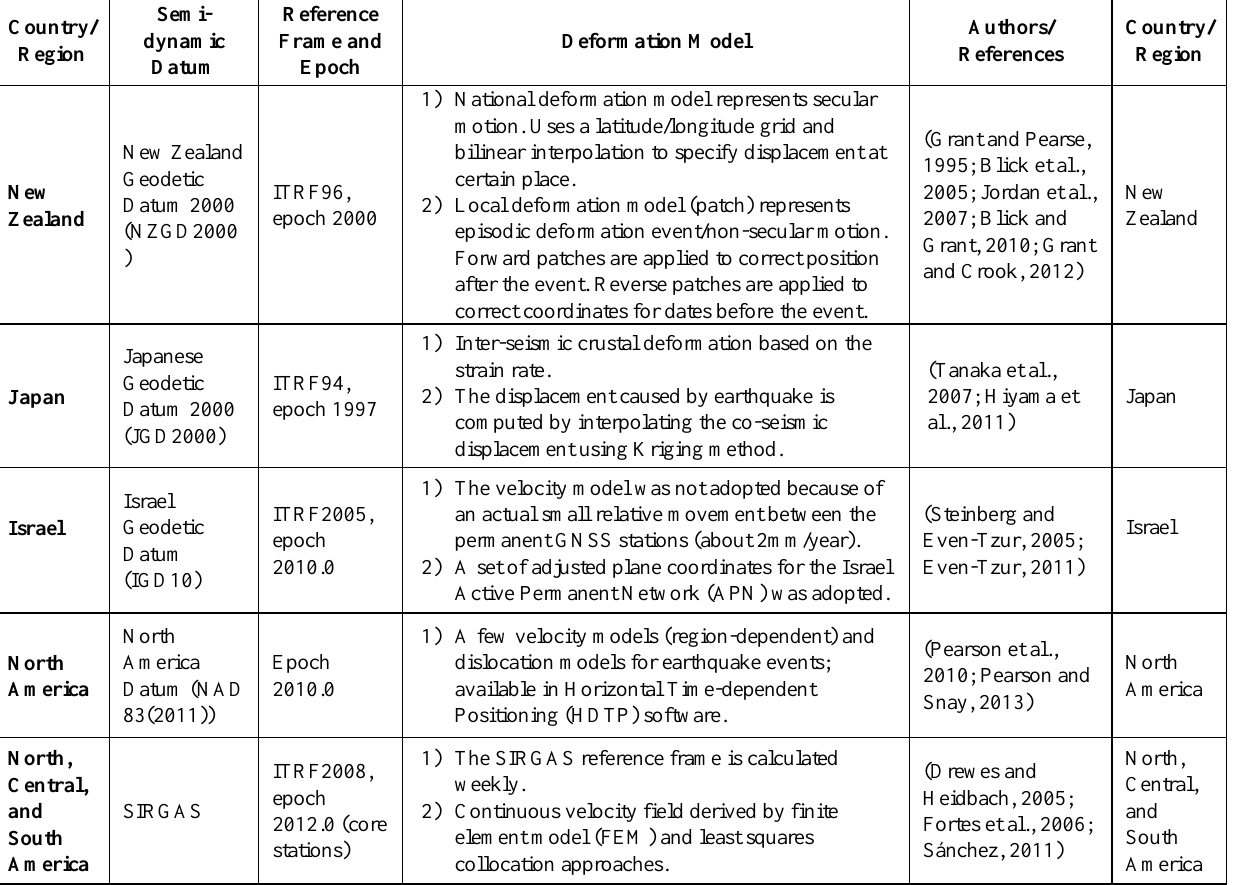
Table 1. Implementation of semi-dynamic datum or similar approaches in several countries and